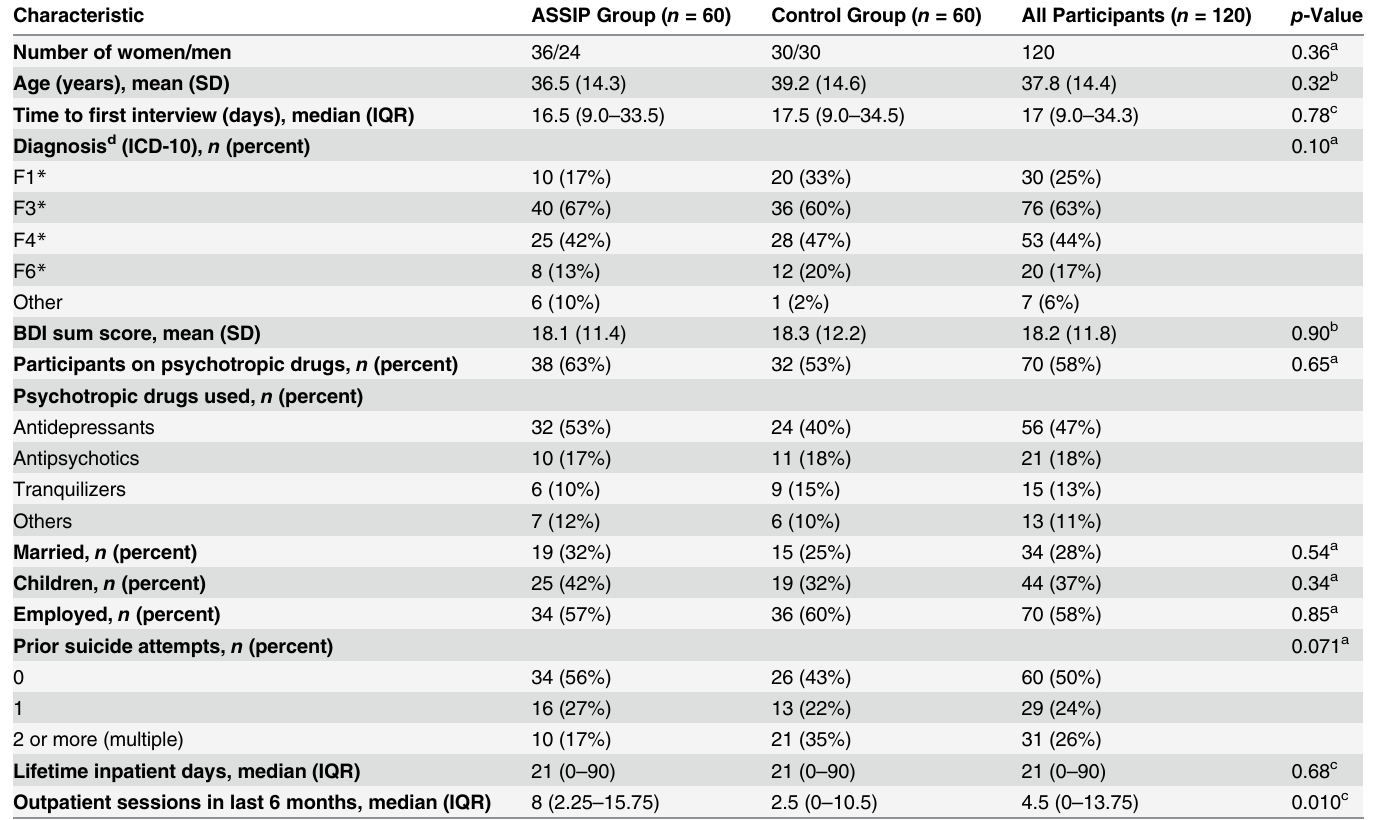
Table 1. Baseline demographic and clinical characteristics of study